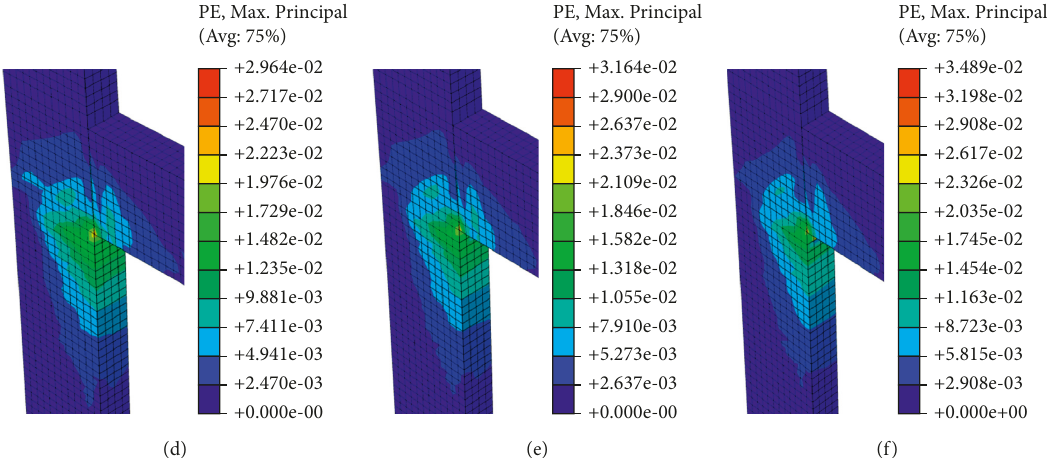
Figure 18: Crack pattern for specimens with various concrete compressive strengths: (a) G2M1, 15MPa; (b) G2M2, 20 MPa; (c) Referential, 25MPa; (d) G2M3, 35 MPa; (e) G2M4, 40MPa; and (f) G2M5, 50MPa.